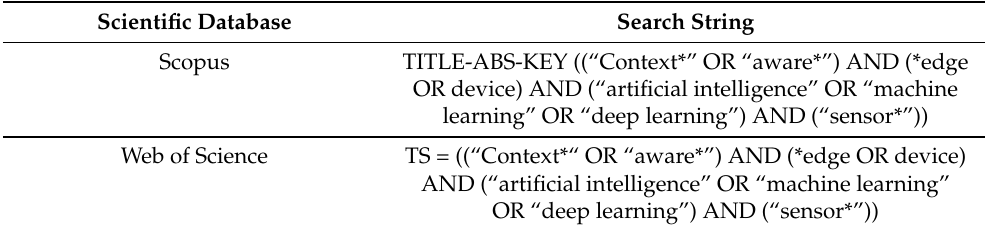
Table 3. Search strings considering the search process strategy with inclusion and exclusion